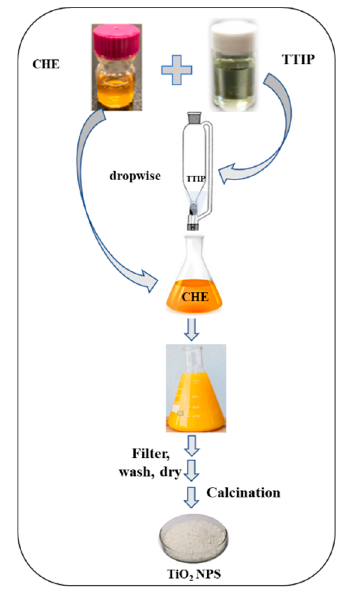
Figure 11. Schematic representation of preparation of porous TiO 2 nanoparticles.